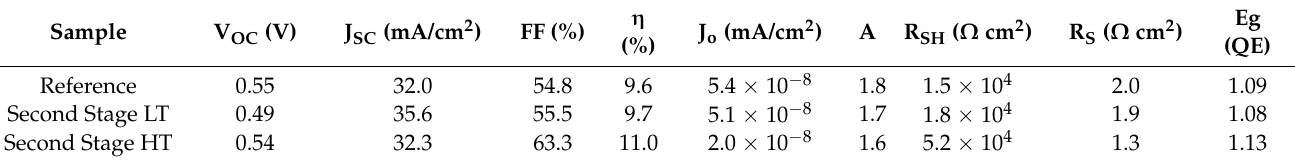
Table 3. Photovoltaic characteristics and diode parameters of the representative cells shown in Figure 4.